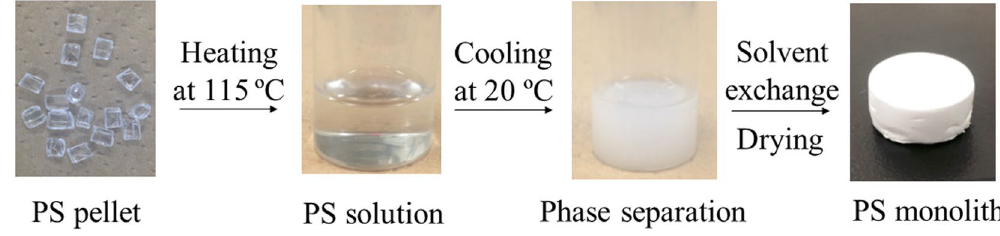
Figure 1. Fabrication procedure of a PS monolith.